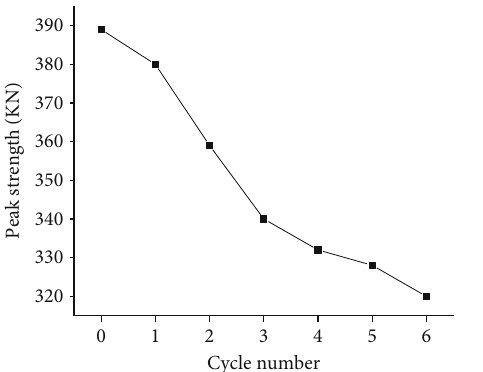
Figure 3: Peak strength of tailing sand under di ff erent numbers of moisture absorption and dehumidi fi cation